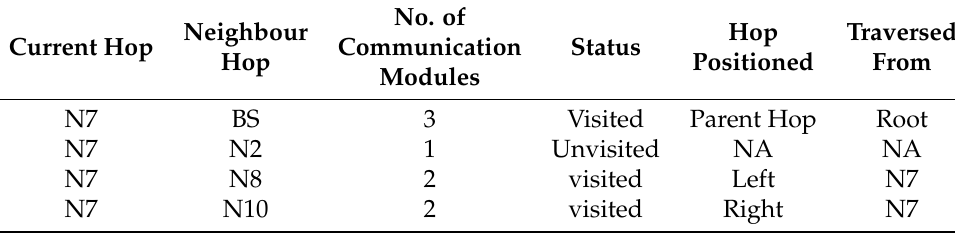
Table 3. The updated left subTree routing table of N2.